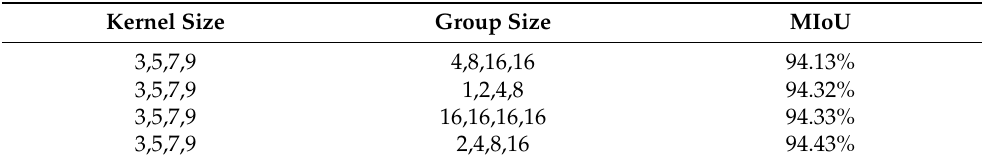
Table 1. MIoU of different group